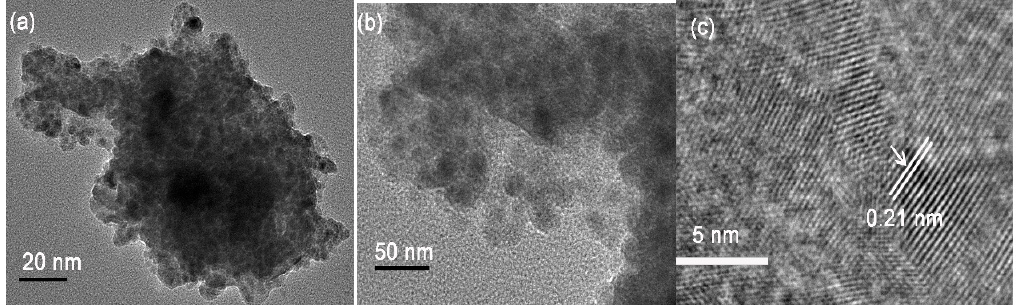
Figure 7. X-ray Diffractometry (XRD) analysis of elemental Cu on ( a ) modified chitosan microspheres (CSM), ( b ) Cu 2 + -loaded modified chitosan microspheres (CSM@ Cu II ), and ( c ) Cu-loaded modified chitosan microspheres (CSM@ Cu 0 ).